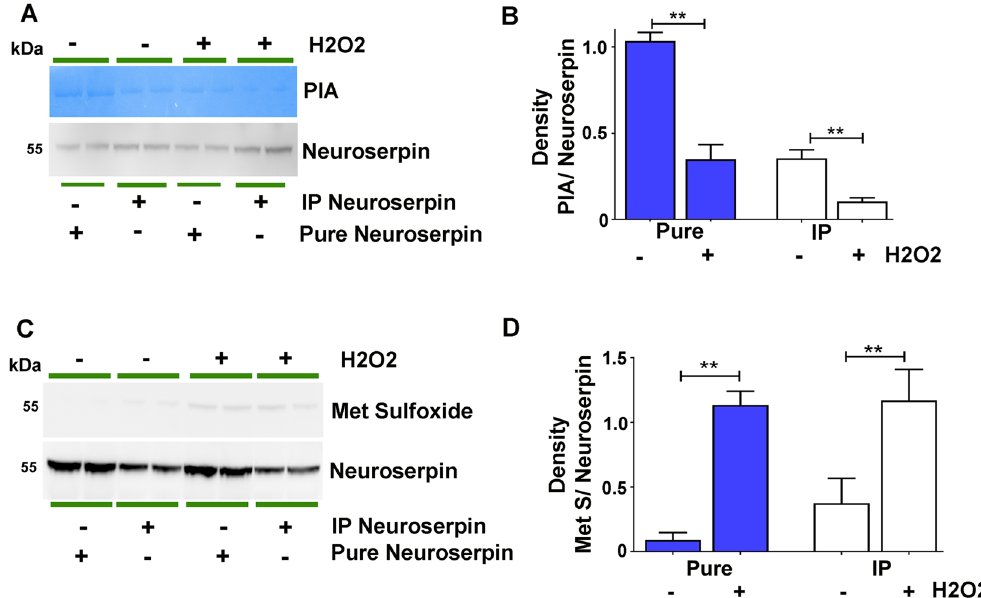
Figure 8. Purified neuroserpin (5 µ g) and immunoprecipitated neuroserpin from the normal human retinas (200 µ g protein) with or without the H2O2 treatment (10 µ M, 1 hr) were subjected to ( A ) gelatin zymography for plasmin inhibitory activity and ( C ) immunoblots probed for met sulfoxide reactivity. ( B ) ( D ) Changes in plasmin inhibitory activity and met sulfoxide reactivity were compared with total neuroserpin blotted in each case and the densitometric data quantified and plotted ( ** p <